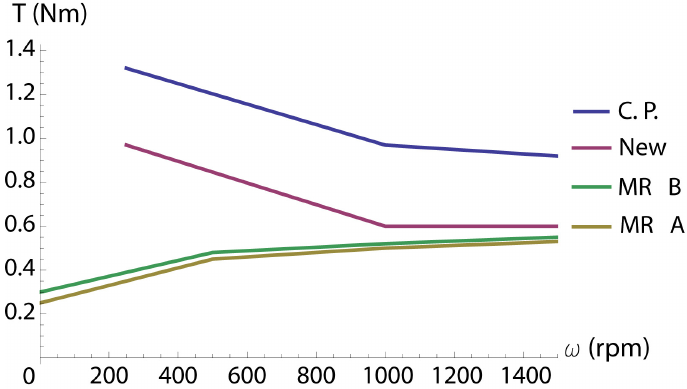
Figure 10: Torque absorbed by current production, innovative vacuum pumps and A and B